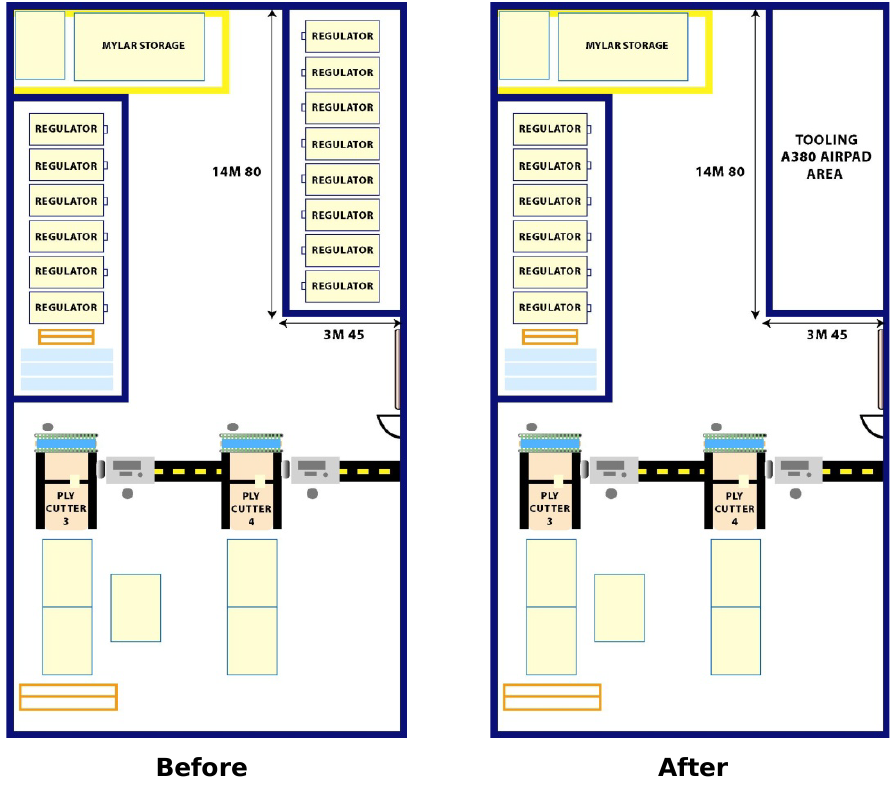
Figure 19. “Floor spaced freed for Value added